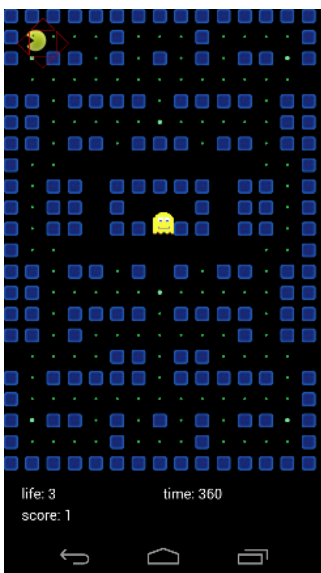
Figure 11. Screenshot of the adaptation of the classic arcade video game Pac Man.